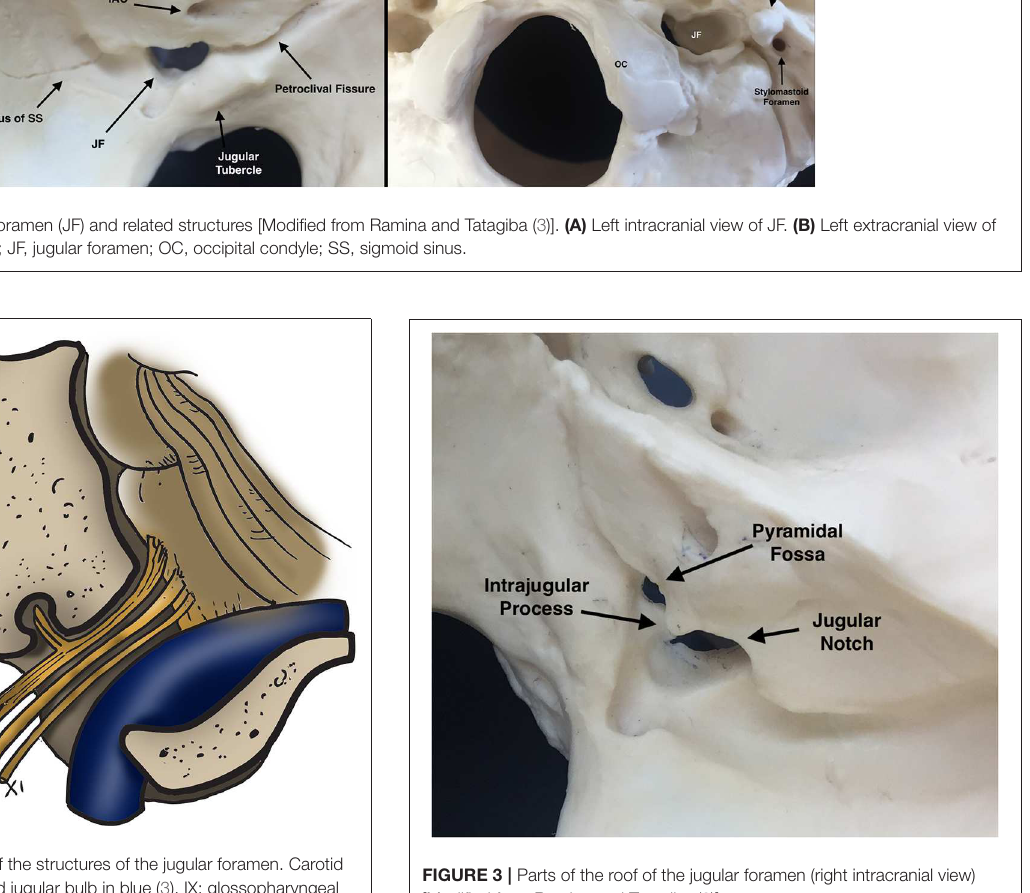
through the middle ear or internal auditory canal, which have and other lesions of the internal auditory